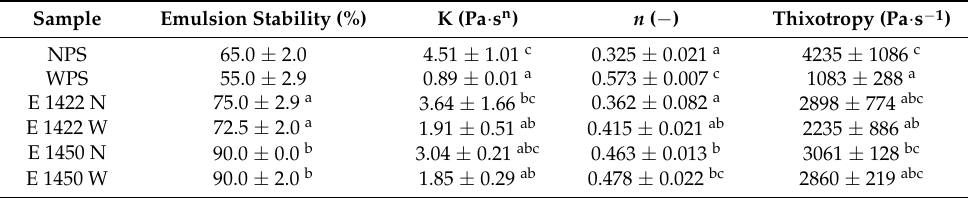
Table 3. Stability of model emulsions made with aerogels and their rheological parameters.